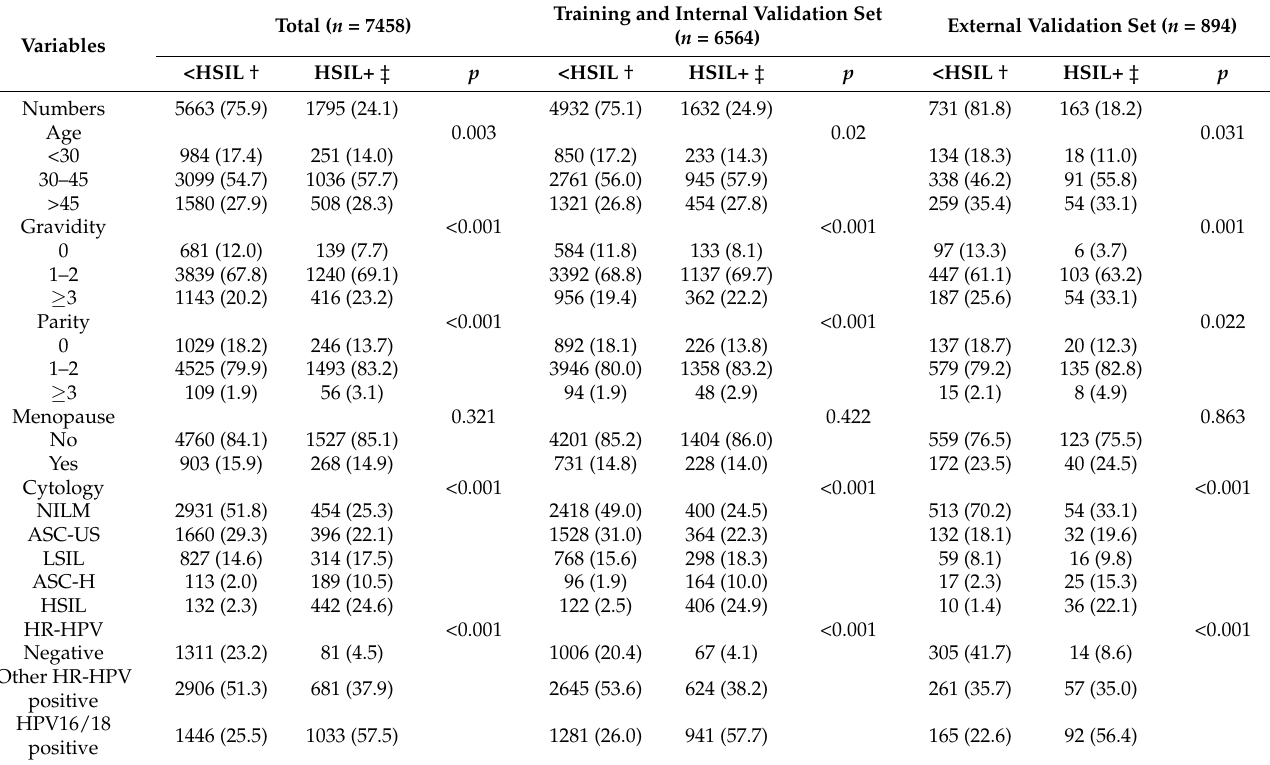
Table 1. Characteristics of the study